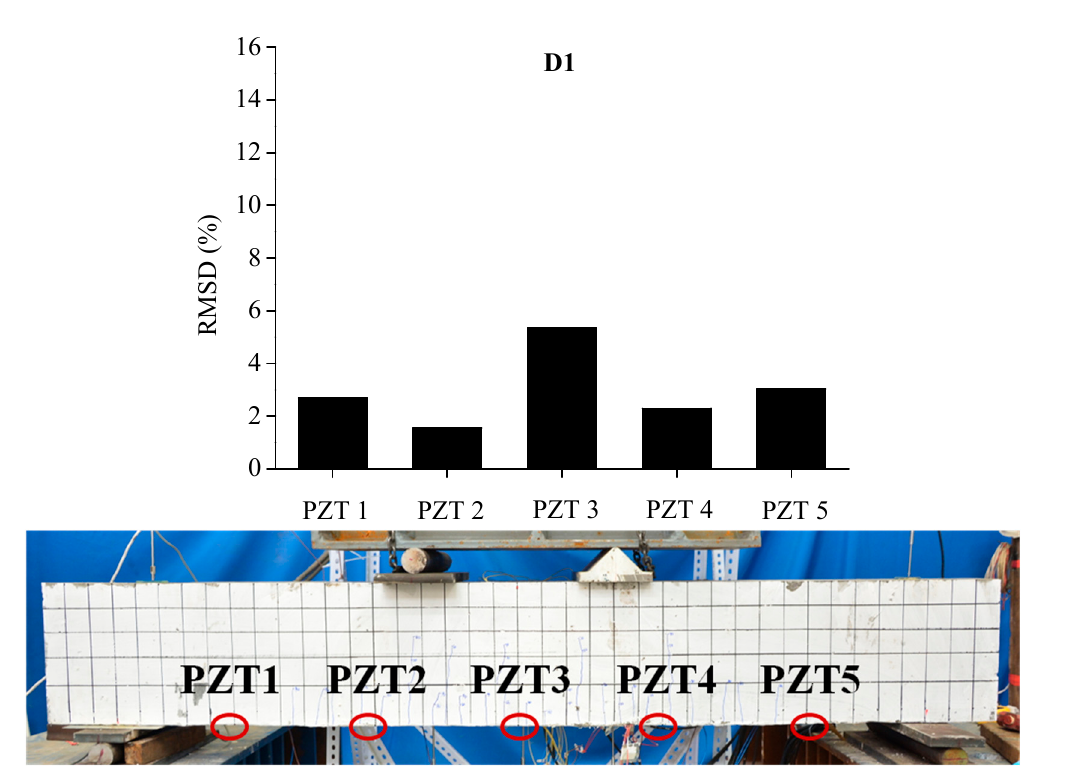
Figure 16. RMSD of each PZT sensor at D1 and the related cracking pattern of BE2.